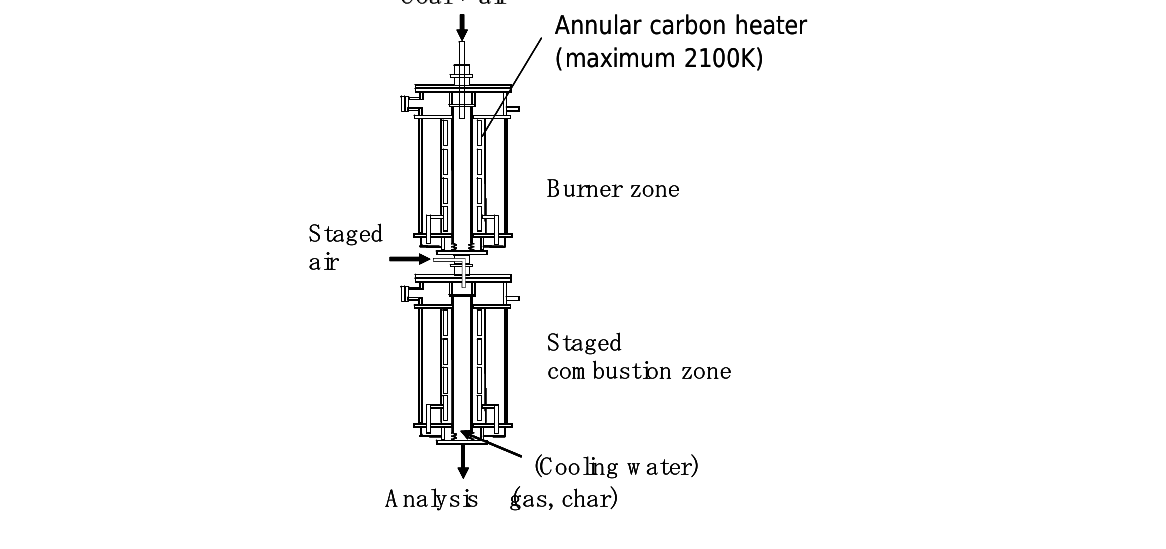
Table 4. Analysis of studied